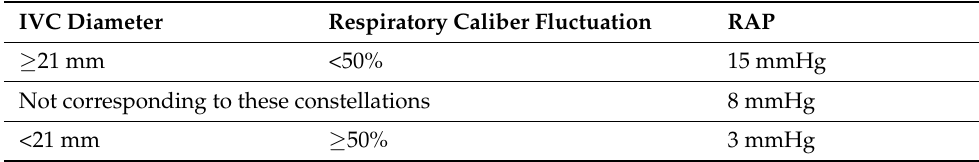
Table 1. Overview of the calculation of the estimated RAP.